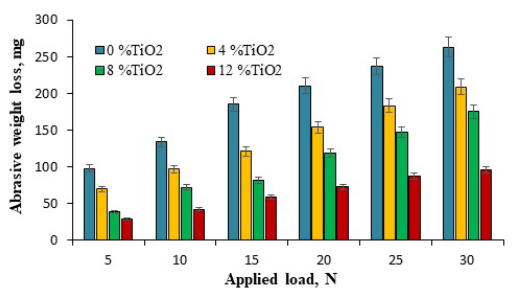
Figure 11. Correlation between abrasive weight loss (mg) and applied loads at different nano-TiO2 contents and sliding distance of 400m.